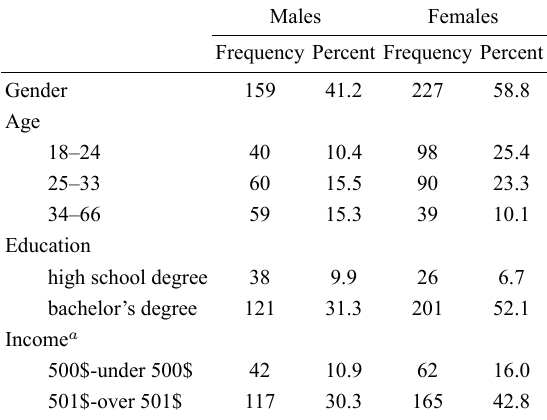
Table 1. Demographic characteristics of the